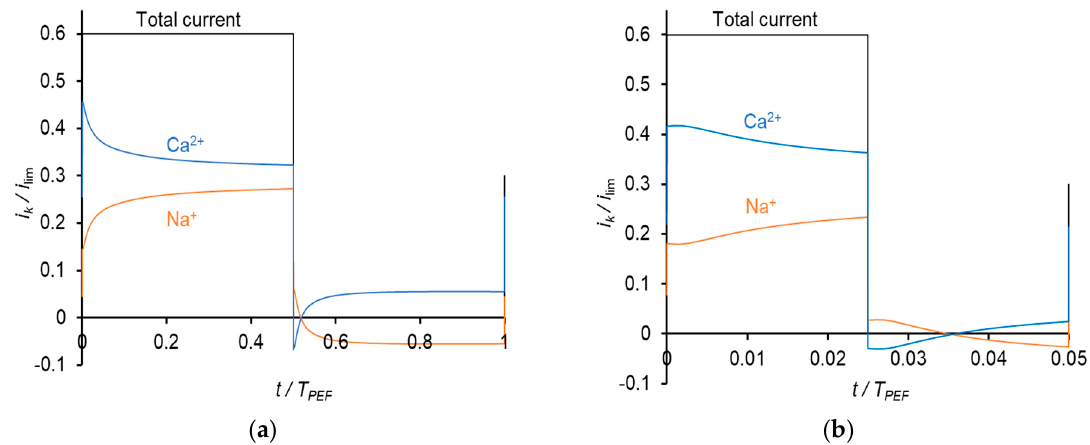
Figure 5. Dependences of partial current densities of Na + and Ca 2+ ions on time at the frequencies of PEF of 0.5 Hz ( a ) and 10 Hz ( b ) at i av = 0.3 i lim .